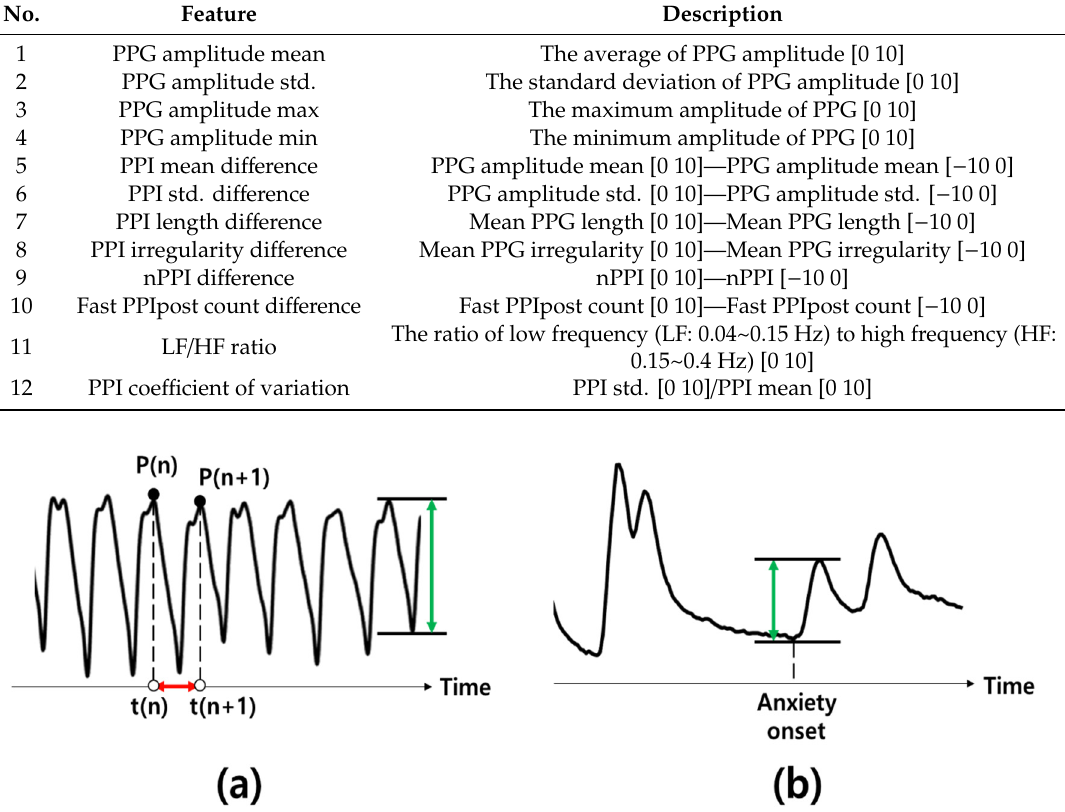
Table 1. The descriptions of photoplethysmography (PPG) features.